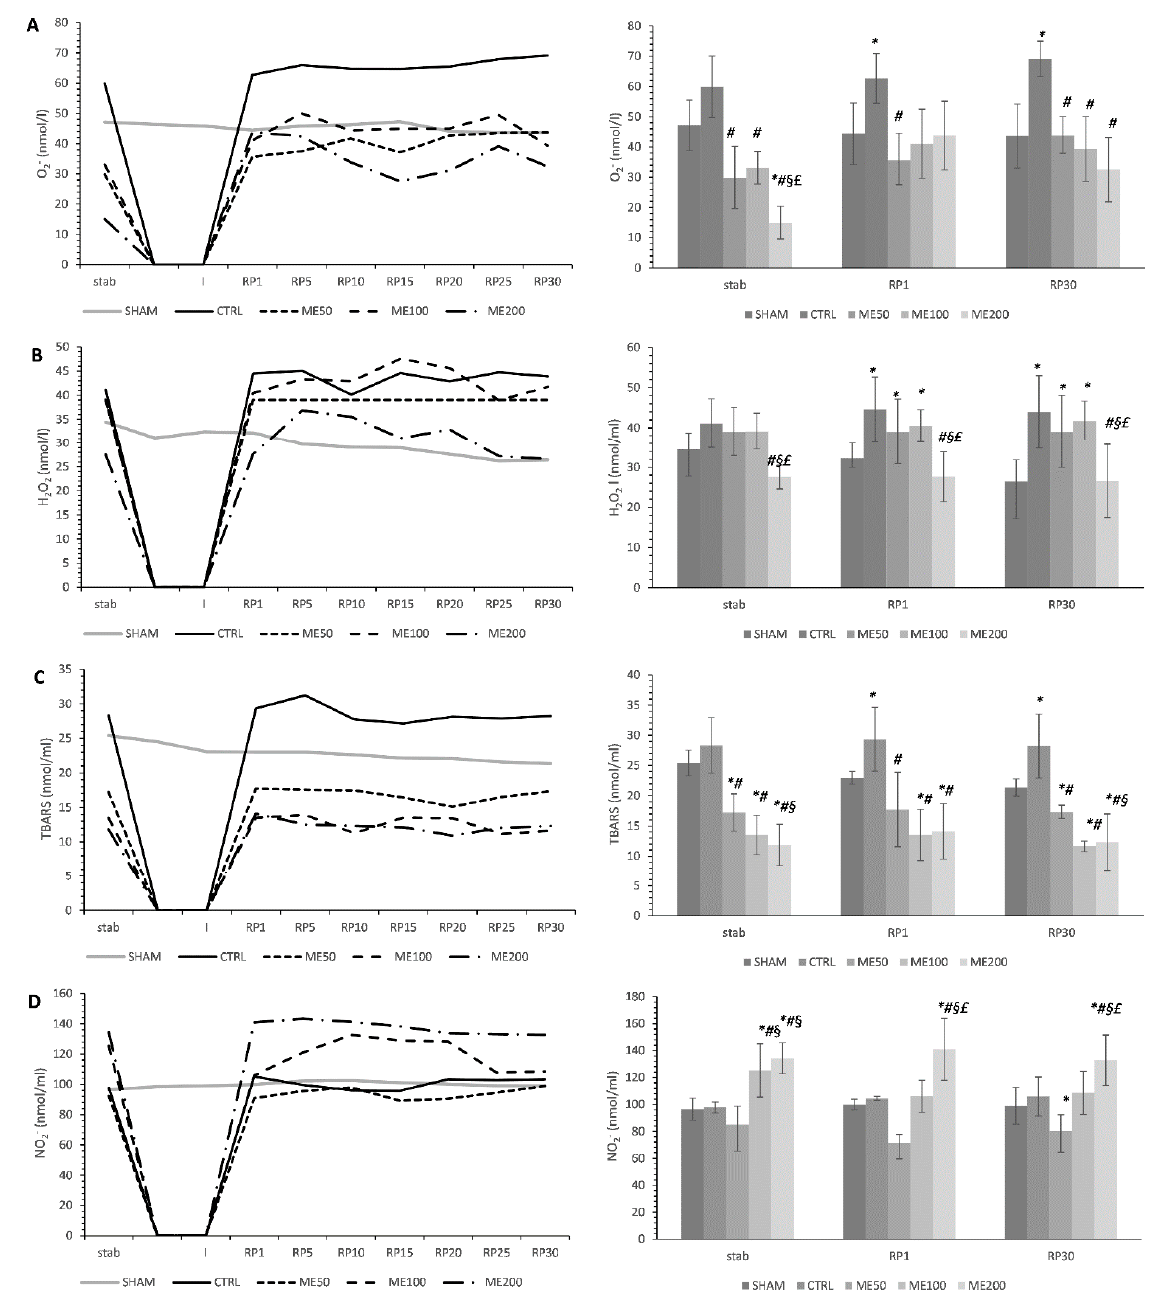
Figure 2. Effects of short-term heart preconditioning with ME on oxidative stress parameters in the coronary venous effluent. ( A ) O 2 − —superoxide anion radical; ( B ) H 2 O 2 —hydrogen peroxide; ( C ) TBARS—index of lipid peroxidation measured as thiobarbituric acid reactive substances; ( D ) NO 2 − —nitrites. All measured parameters of oxidative stress during whole ex vivo protocol are presented on the line graphs (on the left), while the points of interest (stab—stabilization; RP1—1st min of reperfusion; RP30—30th min of reperfusion) used for statistical analysis are presented on the bar graph (on the right). Values are expressed as means ± standard deviation ( n = 8). *—statistical significance at the level of p < 0.05 compared to SHAM; #—statistical significance at the level of p < 0.05 compared to CTRL; §—statistical significance at the level of p < 0.05 compared to ME50 group; £—statistical significance at the level of p < 0.05 compared to ME100